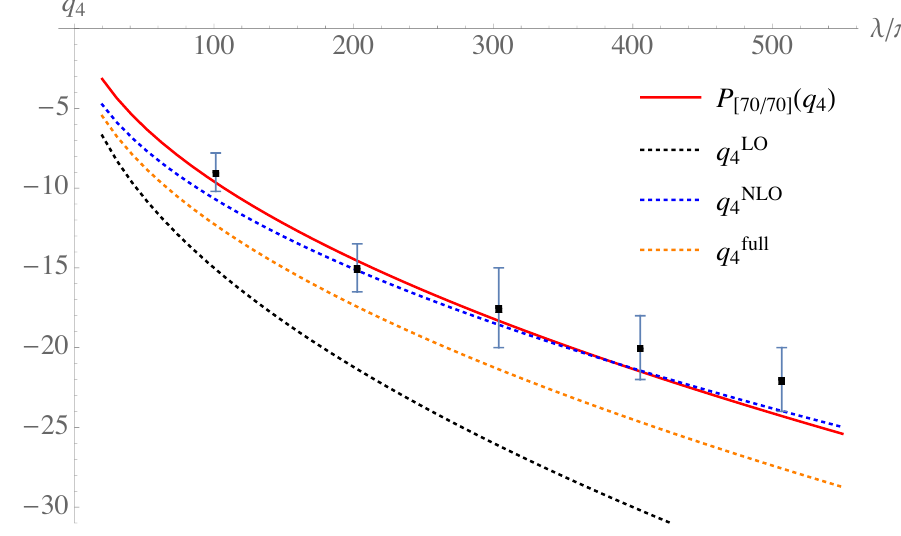
( q 4 ) (red curve), the MC [70 / 70] ( λ ) , q NLO ( λ ) , q full ( λ ) defined in (5.16) and (5.17). We observe the 4 4 4 ( q 4 ) and the MC points (within error bars). Since, [70 / 70] ( λ ) , q NLO ( λ ) , q full ( λ ) to be a good approximation in the range 4 4 4